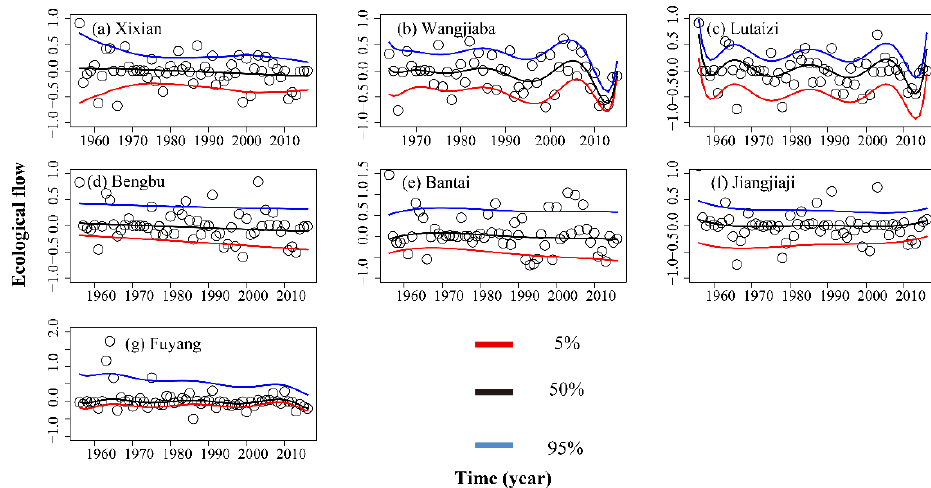
Figure 14. Centile curves of stationary ecological instream flow.